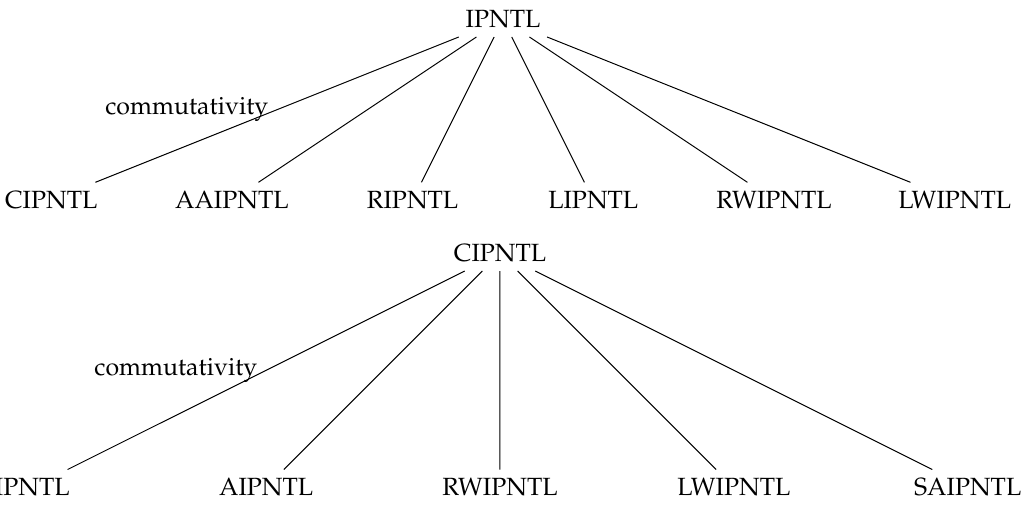
Figure 1. Inverse property neutrosophic triplet loop (NTL) Hasse diagrams. AAIP: antiautomorphic inverse property; AIP: automorphic inverse property; CIP: cross inverse property; LCIP: left cross inverse property; LIP: left inverse property; LWIP: left weak inverse property; RCIP: right cross inverse property; RIP: right inverse property; RWIP: right weak inverse property; SAIP: semi-automorphic inverse property; WIP: weak inverse